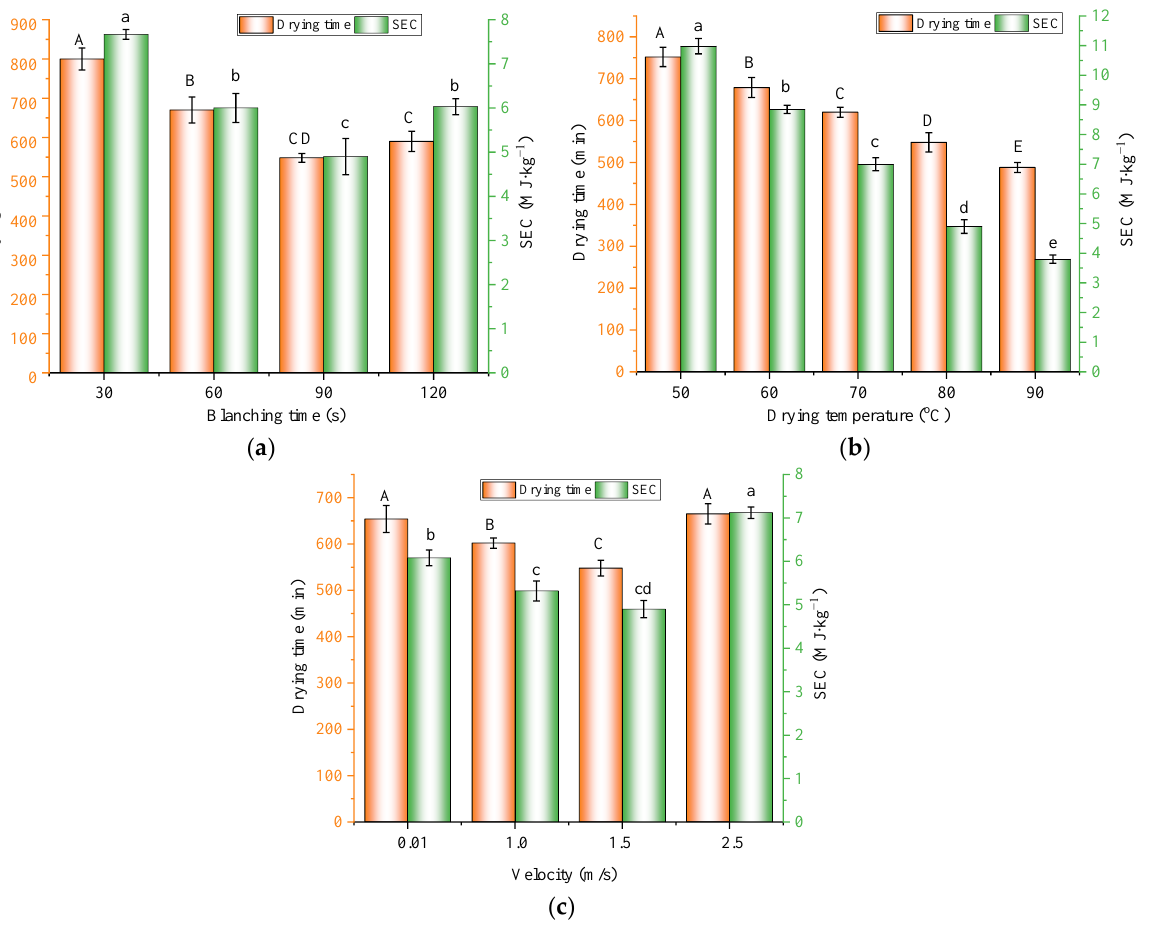
Figure 5. Effect of BT , T , and v on the drying time and SEC for ( a ) an air velocity of 1.5 m/s and a heating temperature of 80 °C, ( b ) a blanching time of 90 s and an air velocity of 1.5 m/s, and ( c ) a blanching time of 90 s and a heating temperature of 80 °C. Note: different characters on the tops of columns of the same color denote significant differences between the mean values ( p < 0.05).